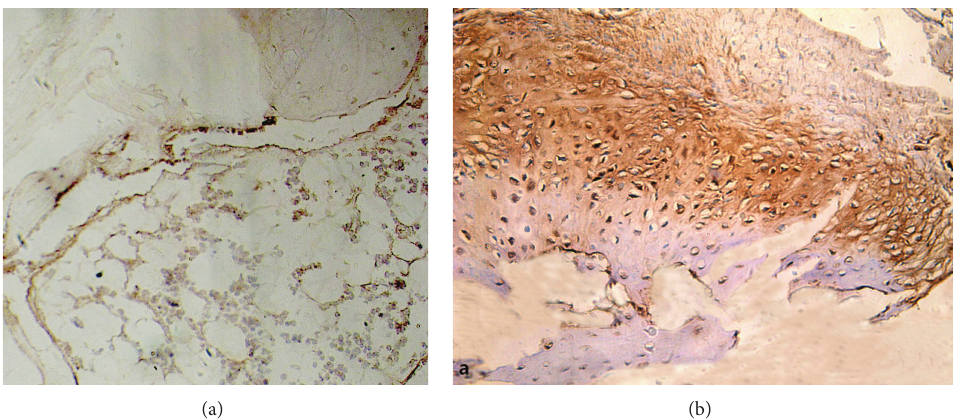
Figure 6: (a) OC expression slightly increased in PMMA-bone interface in 1 week, 20 × 10SP + HE. (b) OC expression in PMMA-bone interface in 4 weeks, when chondrocytes were found to be growing in cluster and differentiating to woven bone, 20 × 10SP + HE.